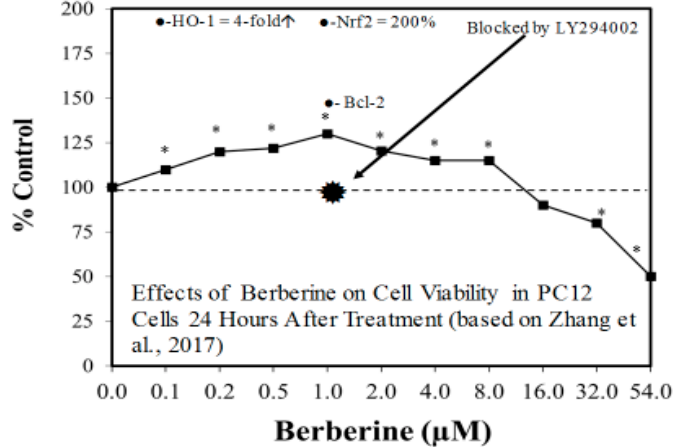
Figure 6. Effects of berberine on cell viability in PC12 cells (i.e., Parkinson’s disease cellular model) 24 h after treatment (Source: Zhang et al. [69]).